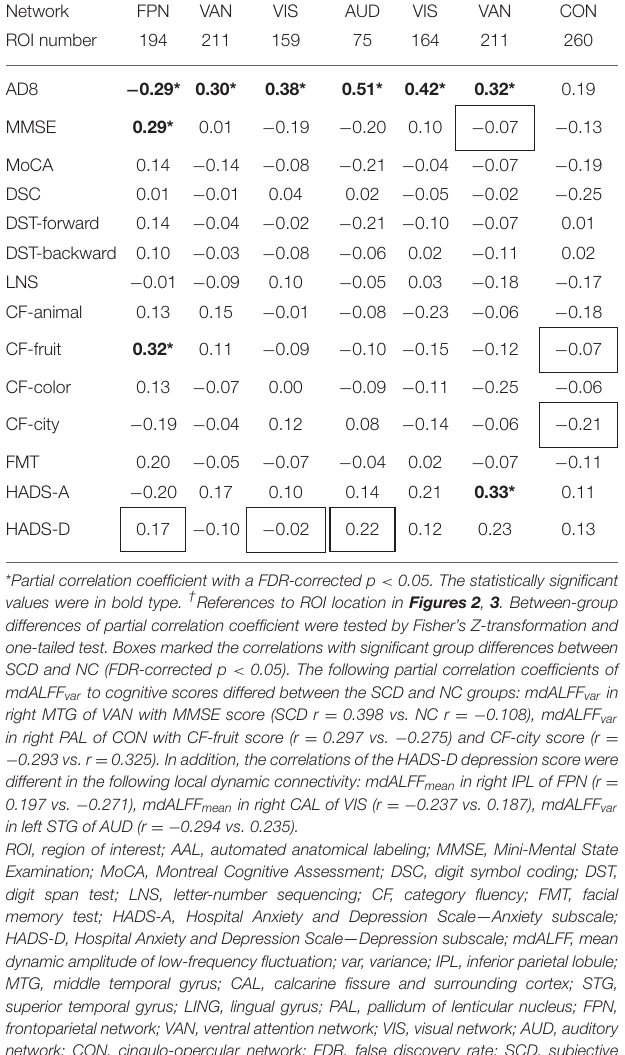
ROI(a) ROI(b) ROI(c)